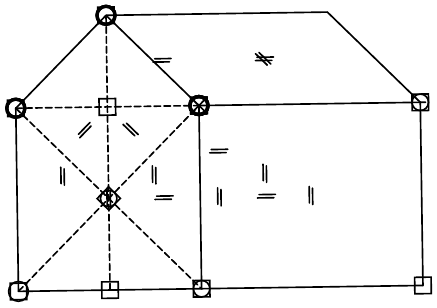
Figure 8. Drawn wireframe model of a building with gable roof in parallel projection. The construction with 14 segments features 45 constraints of which 21 are required. The dashed auxiliary lines enforces eaves at the same height and a symmetric